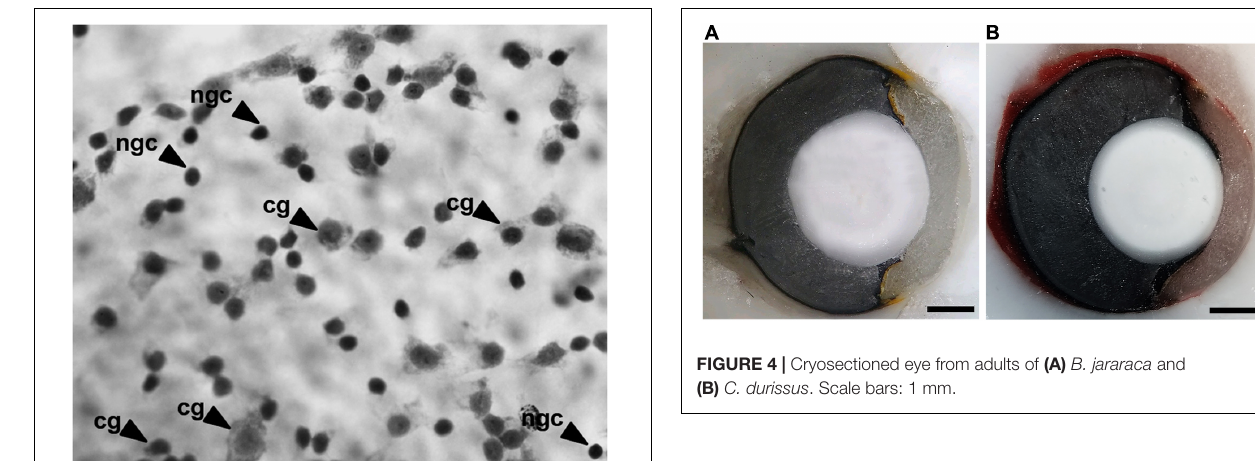
is the ratio between the counting frame and the sampling grid (Coimbra et al.,